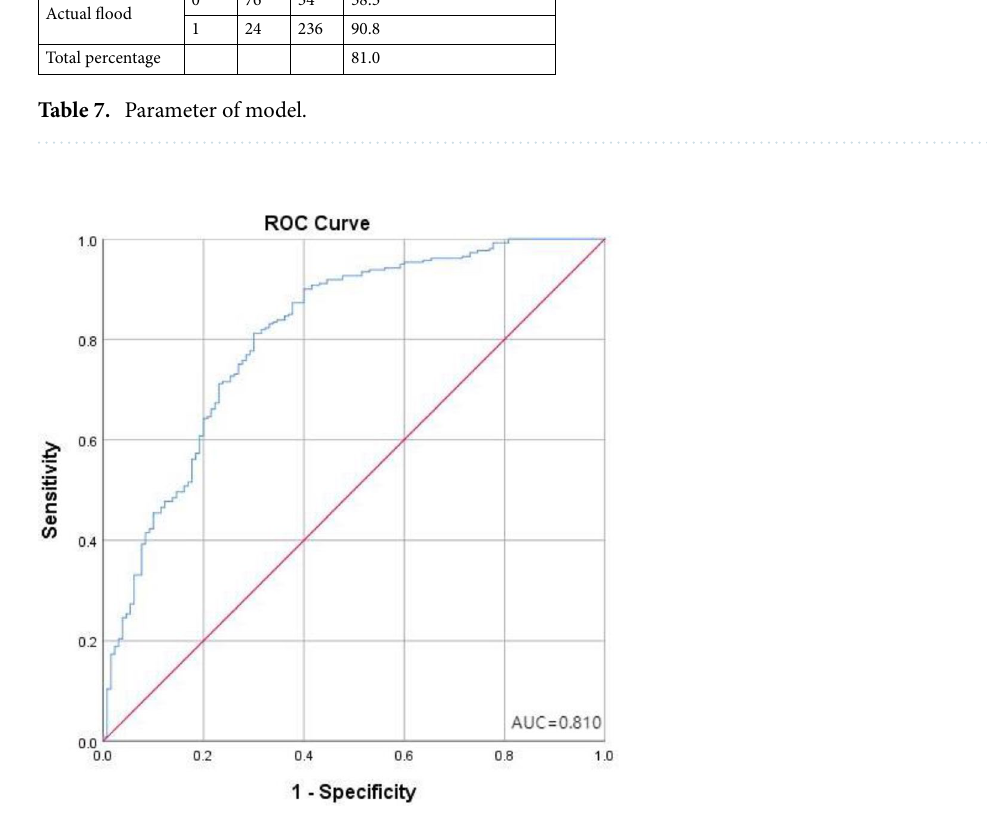
Figure 5. AUC value of the models for calibration and ROC